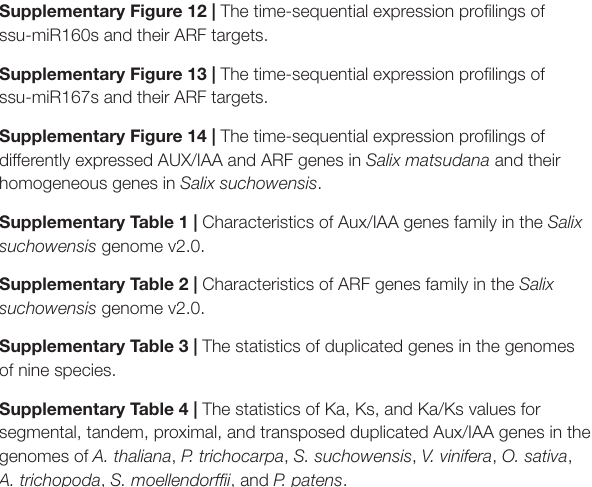
Supplementary Figure 12 | The time-sequential expression profilings of ssu-miR160s and their ARF targets.